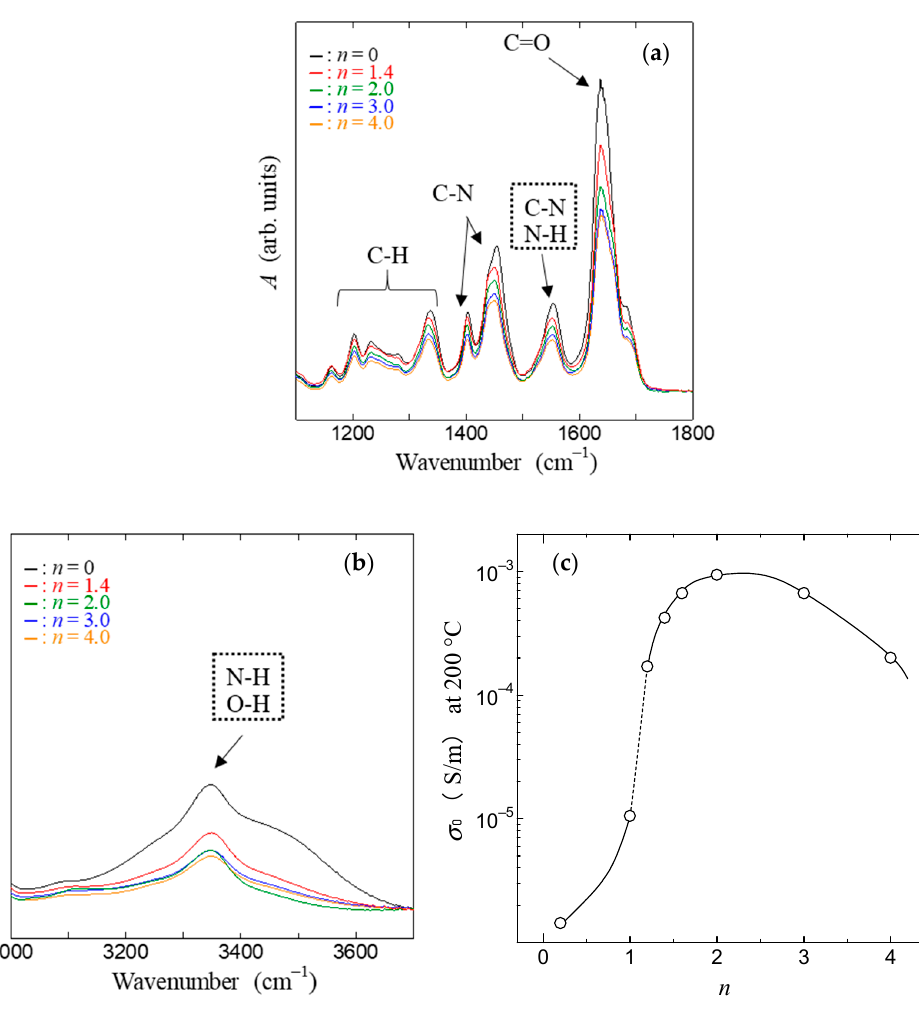
Figure 9. FT-IR spectra and proton conduction in imidazole–collagen composite films with different imidazole contents. ( a ) FT-IR spectra (500 cm − 1 to 1800 cm − 1 ) of imidazole–collagen composite for each imidazole content; ( b ) FT-IR spectra (3300 cm − 1 to 3700 cm − 1 ) of imidazole–collagen composite film for each imidazole contents composite films at different concentrations; ( c ) the relation between proton conductivity and imidazole content n at 200 °C.